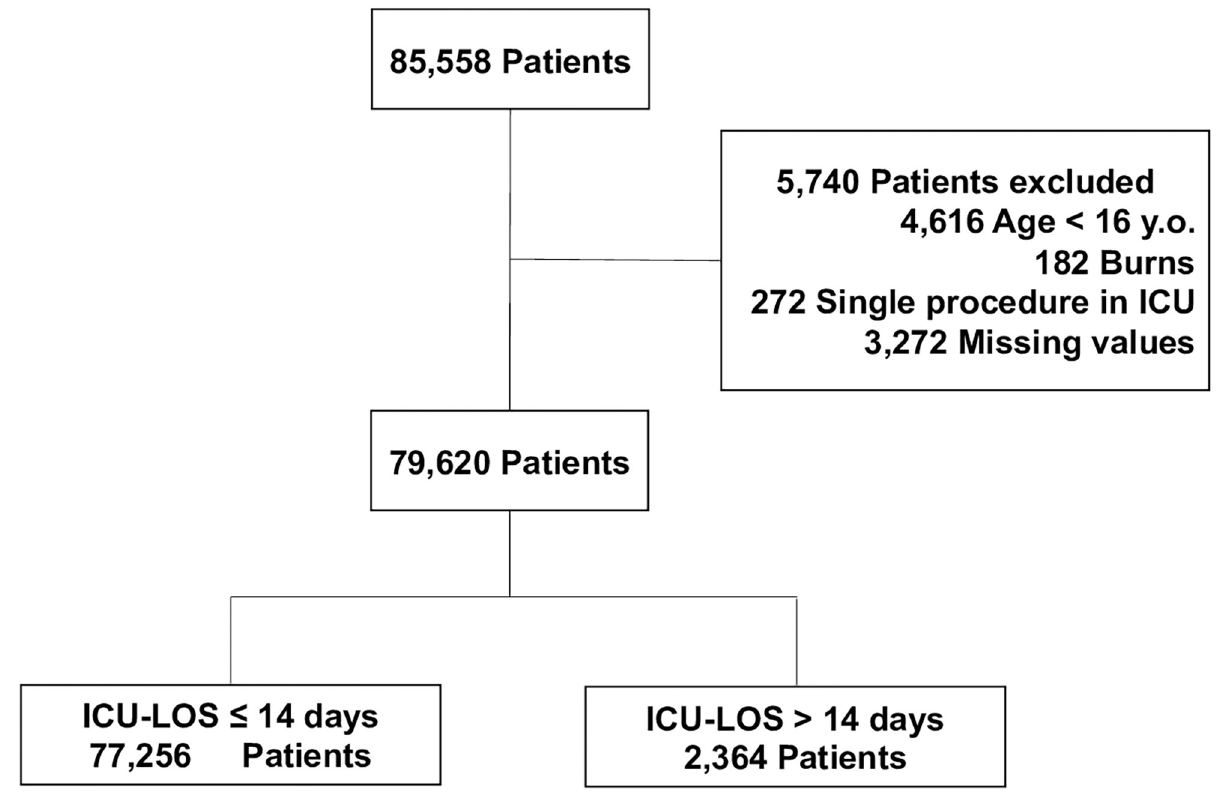
Fig 1. Flowchart outlining patient selection and grouping process.